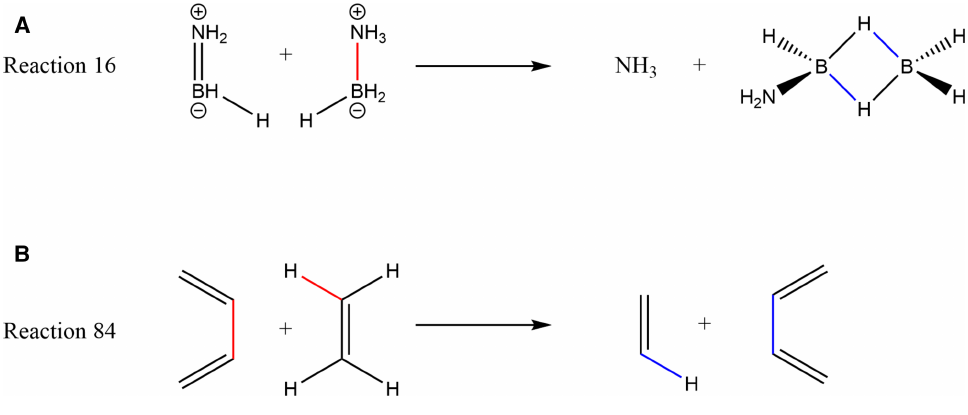
Figure 3 The two reactions not found by the procedure. Bonds broken in the reaction are indicated in red, bonds formed in blue.